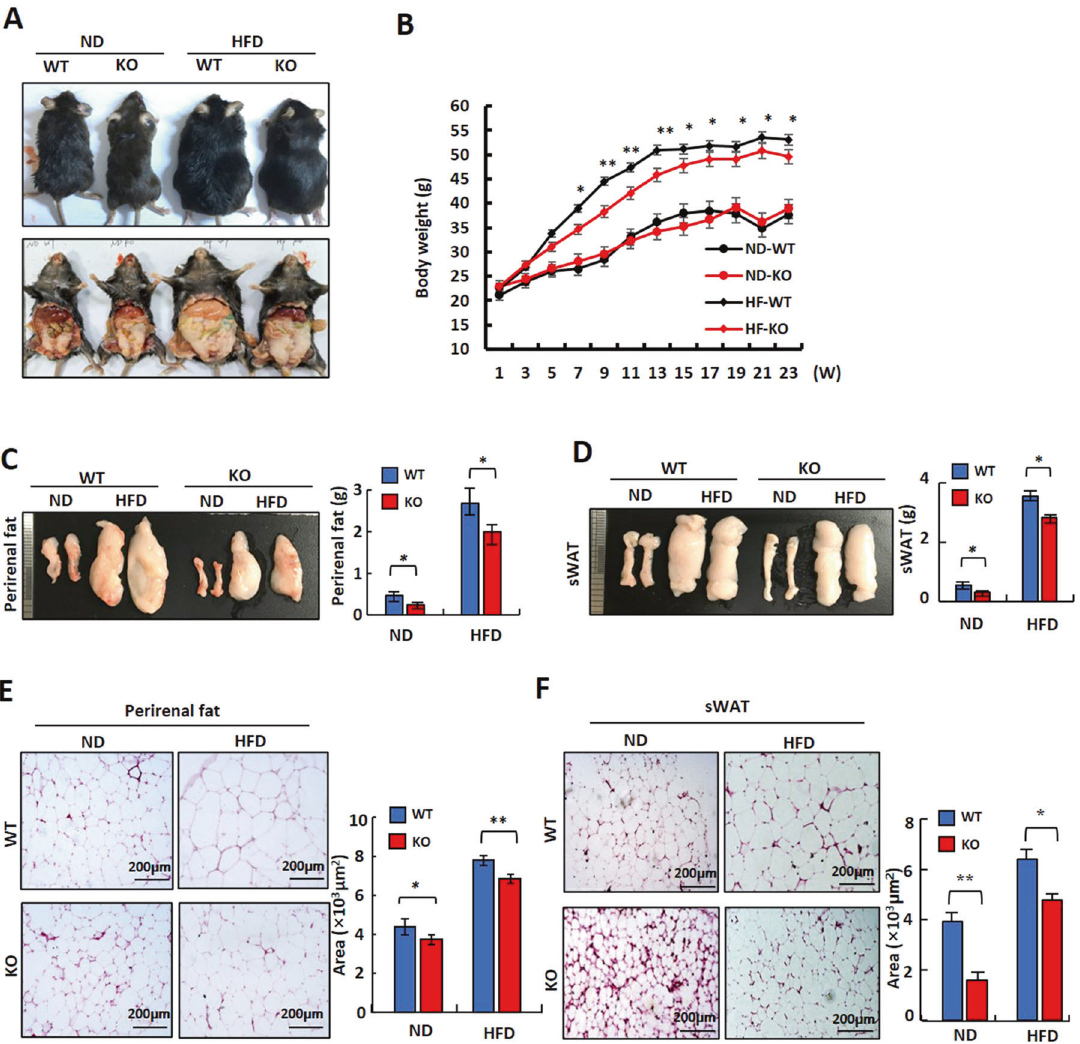
Fig. 2 Reduced adiposity in LXN-de fi cient mice. A Representative pictures for WT and LXN − / − mice after feeding with HFD or ND for 23 weeks. B Comparison of body weight changes between WT and LXN − / − mice during the course of ND or HFD induction ( n = 8). ND-WT, WT mice fed with ND; ND-KO, LXN − / − mice fed with ND; HF-WT, WT mice fed with HFD; HF-KO, LXN -/- mice fed with HFD. C , D Representative pictures for perirenal adipose tissue ( C ) and subcutaneous adipose tissue ( D ) collected from WT and LXN -/- mice after 23 weeks of HFD or ND feeding, and analysis of the weight. E , F Representative pictures for H&E-stained perirenal adipose sections ( E ) and subcutaneous adipose sections ( F ) collected from WT and LXN -/- mice after 23 weeks of HFD or ND feeding. Scale bar = 200 μ m. Mean adipocyte size was calculated. All results were presented as mean ± SD, and P values were calculated with use of Student t test. * P < 0.05, and ** P <